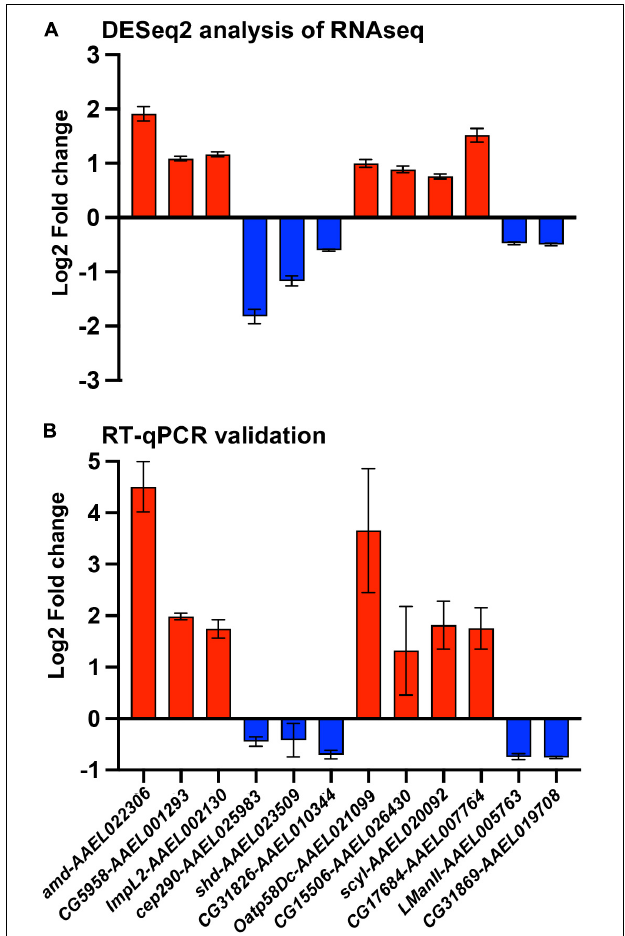
FIGURE 4 | Validation of A. aegypti ovary genes differentially expressed between DENV-2 and mock infected mosquitoes. (A) Fold change of 12 differentially expressed genes from a DESeq2 analysis. (B) Validation of the 12 selected genes by RT-qPCR from mosquito ovaries 3 days post mock or DENV-2 infectious blood meal. The average fold change from two independent biological replicates, repeated at least three times and normalized against A. aegypti actin gene. Red colored bars represent upregulated genes, and blue colored bars represent downregulated genes.